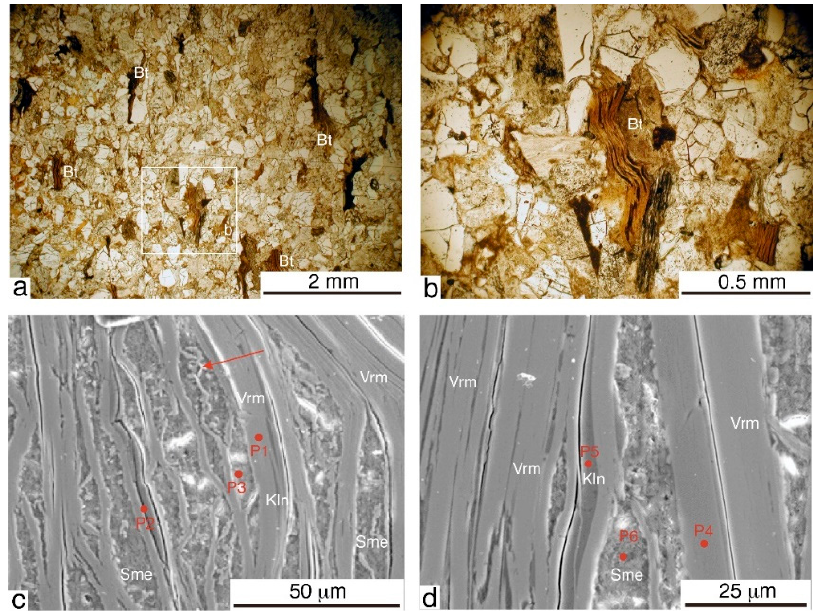
Figure 6. Microphotographs of deformation bands in outcrop sample KT1. See Figure 1b for the locality. ( a ) Phyllosilicate bands. Note that extended biotite grains aligned parallel to the bedding plane (the short dimension of the microphotograph). ( b ) Enlargement of the part enclosed by a white frame shown in ( a ). Note that the biotite detrital grains were extended and kinked due to slipping along the cleavages. ( a , b ) Under plane-polarized light. ( c , d ) SEM-BSE microphotographs of altered biotite grains. Note that kinking and creation of pore space were caused by cleavage fracturing in biotite grains, and peeled-off biotite selvages were curled in ( c ) (shown by an arrow). In ( c , d ), authigenic smectite grew in the pore spaces. Measurements points for microchemical analysis with SEM-EDS are indicated by filled red circles. See Table 3 for the compositions. Bt, biotite; Vrm, vermiculite; Kln, kaolinite, Sme, smectite.